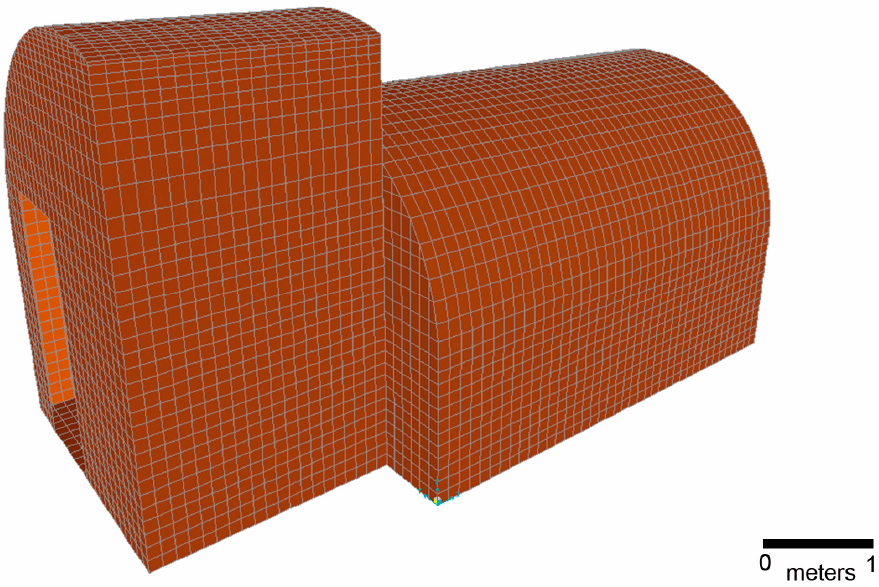
Figure 9. Generation of the FEM model of the cellar from laser